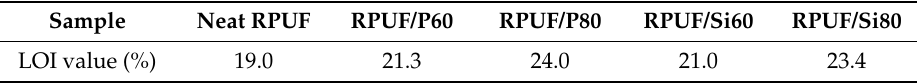
Table 5. RPUF Limiting Oxygen Index (LOI) values.